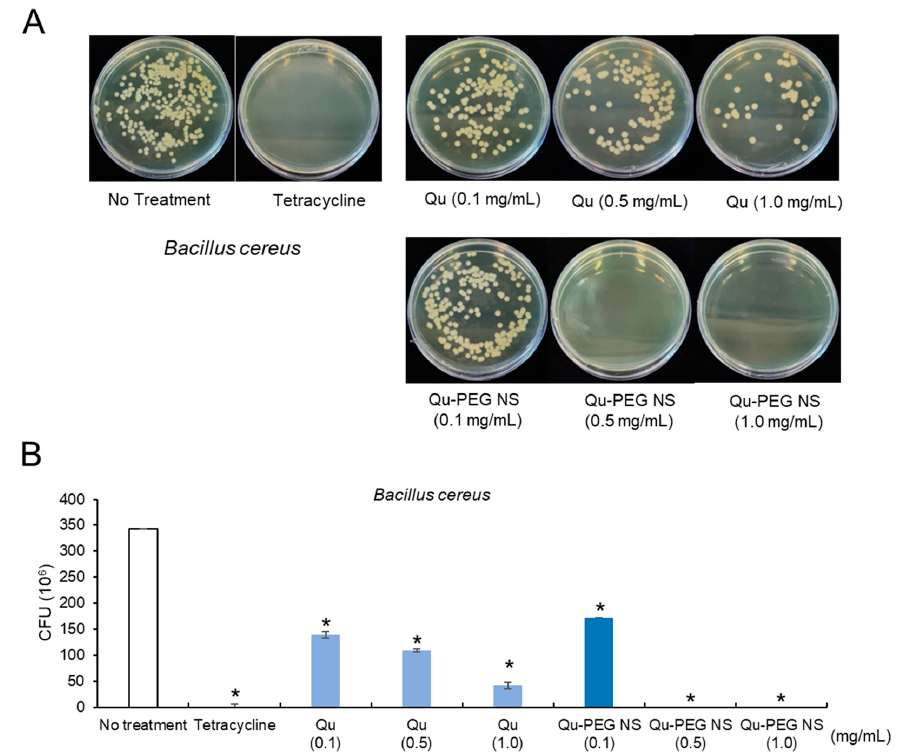
Figure 12. Antibacterial activity of Qu and Qu-PEG NS against B. cereus ( A ) Colony forming on growth medium and ( B ) Number of colonies forming units, * p < 0.05 significant difference compared to control.